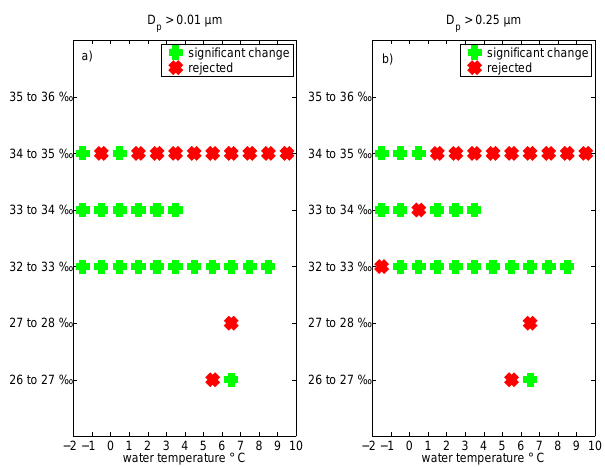
Fig. 9. Green markers show significantly lower particle number concentrations for the salinity to the left of the markers compared to the adjacent higher salinity bin by applying the two-sample Kolmogorov-Smirnov test. The red markers show a rejection of the hypothesis. (a) D p > 0 . 01µm (b) D p > 0 .